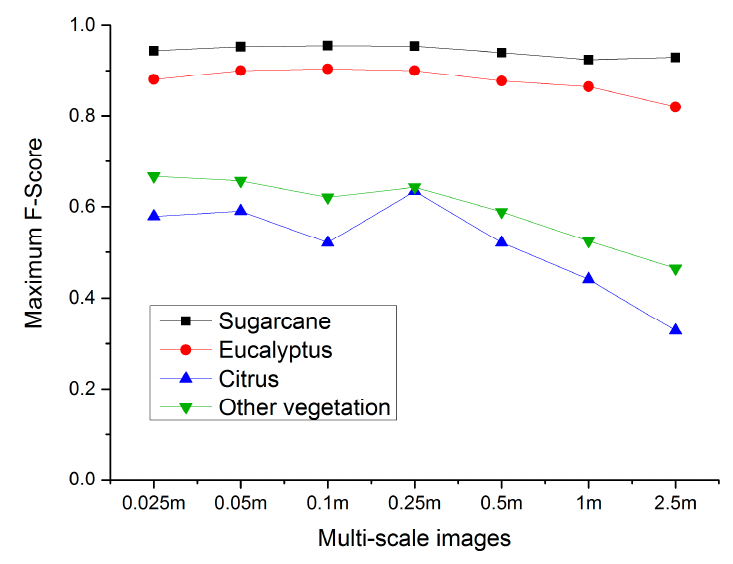
Figure 11. Maximum F-Score variation of various vegetation types in multi-scale images.